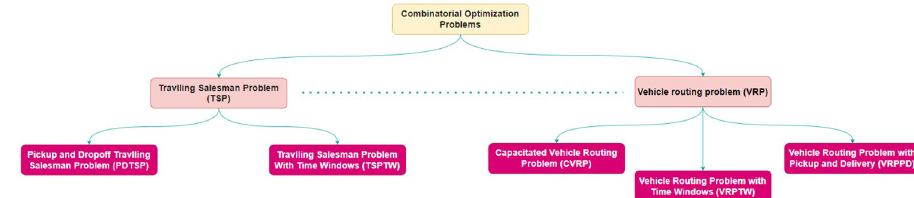
Fig 1. A subset of combinatorial optimization problems (COP)